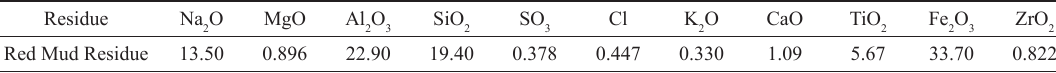
Table 2. Nominal composition (amount % mass), in oxides, of Red Mud. Residue Red Mud Residue